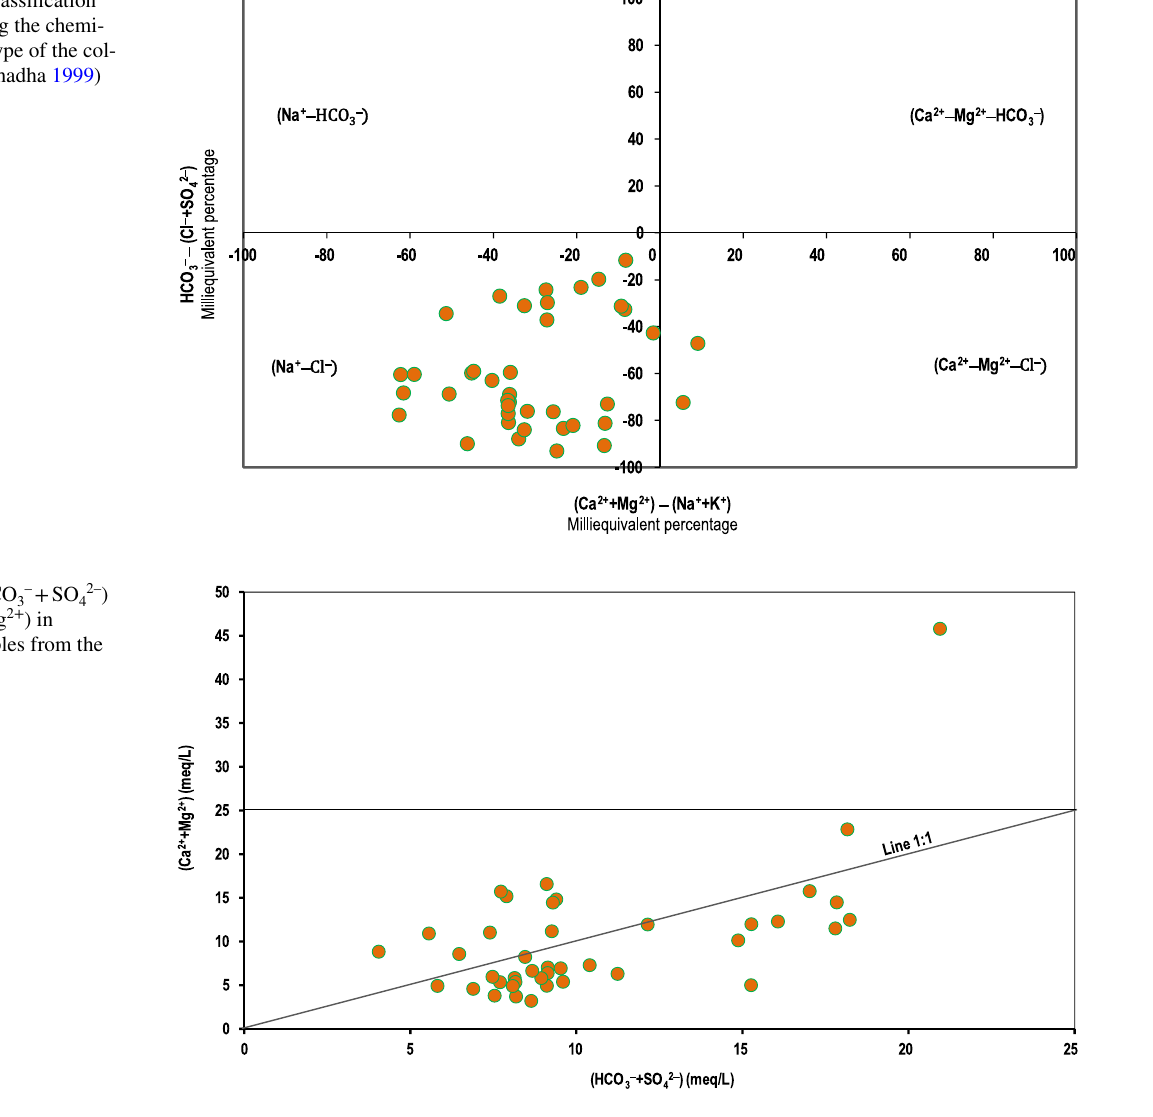
Fig. 5 Chadha's classification diagram explaining the chemi- cal groundwater type of the col- lected samples (Chadha 1999)